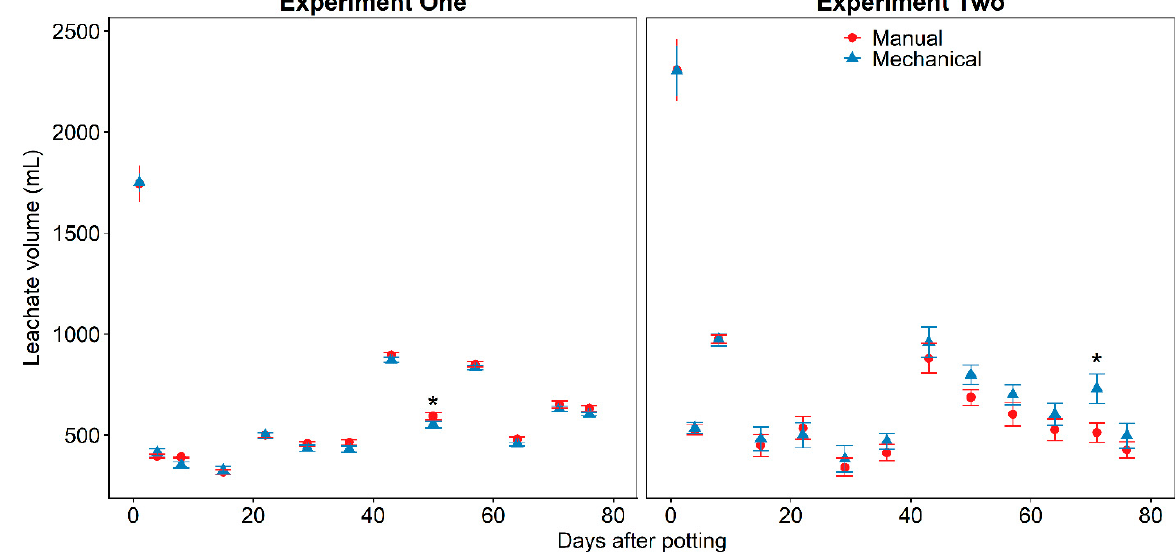
Figure 1. Mean leachate volume from unplanted (Experiment One) or (Experiment Two) planted Douglas fir bark substrate with either manually or mechanically incorporated Osmocote Plus 15-9-12 controlled-release fertilizer. Asterisks aligned with days after potting indicate a significant difference ( p < 0.05) in leachate volume between manually and mechanically incorporated controlled-release fertilizer. Error bars are standard error ( n = 10) of the mean. Table 1. Mean total salt, ammonium-nitrogen, nitrate-nitrogen, and percent applied inorganic nitrogen leached from Douglas fir bark substrate with Osmocote Plus 15-9-12 controlled-release fertilizer incorporated either mechanically or manually and unplanted (Experiment One) or planted (Experiment Two). Different letters next to values in the same column indicate significant difference ( p < 0.05) between manually or mechanically incorporated controlled-release fertilizer on day 76.